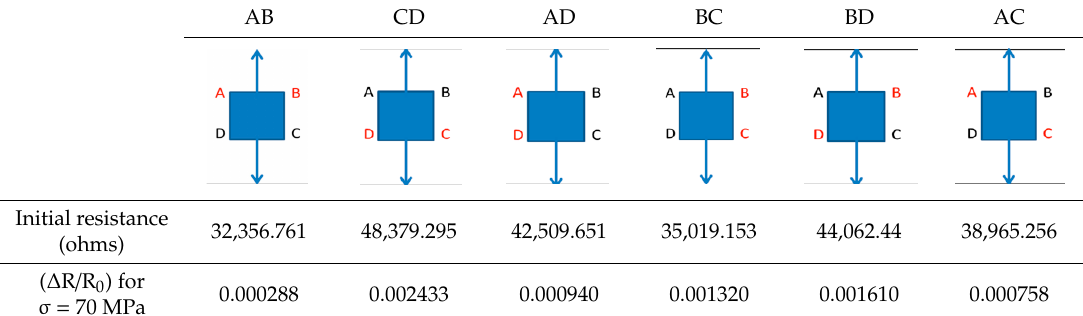
Table 3. Results from a solid square doped adhesive bonded to aluminum.